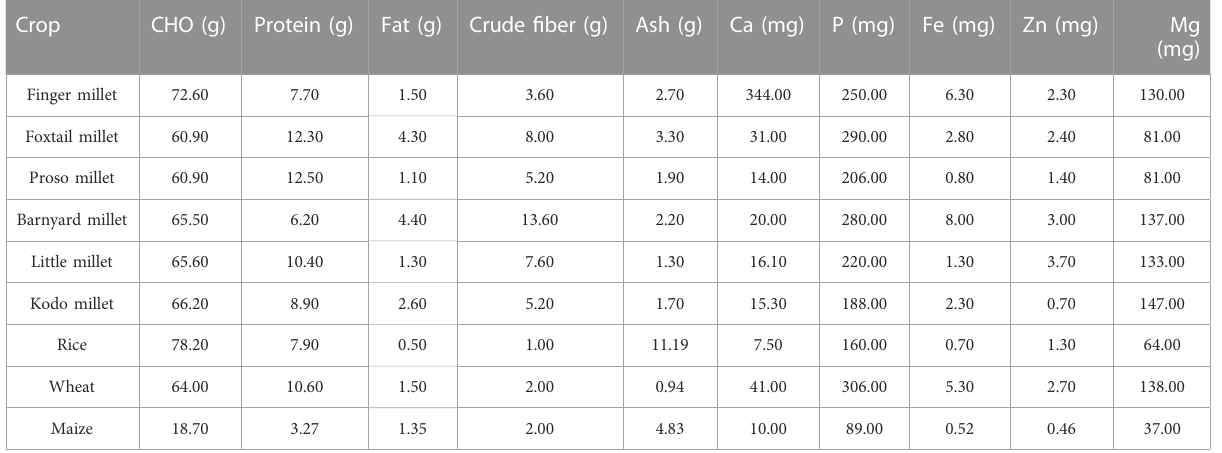
TABLE 1 Nutritional composition of small